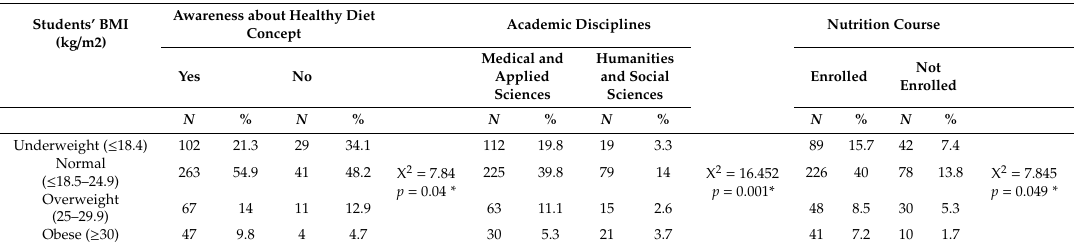
Table 6. Association between BMI and academic discipline and nutrition course attendance ( n = 564). Students’BMI (kg /